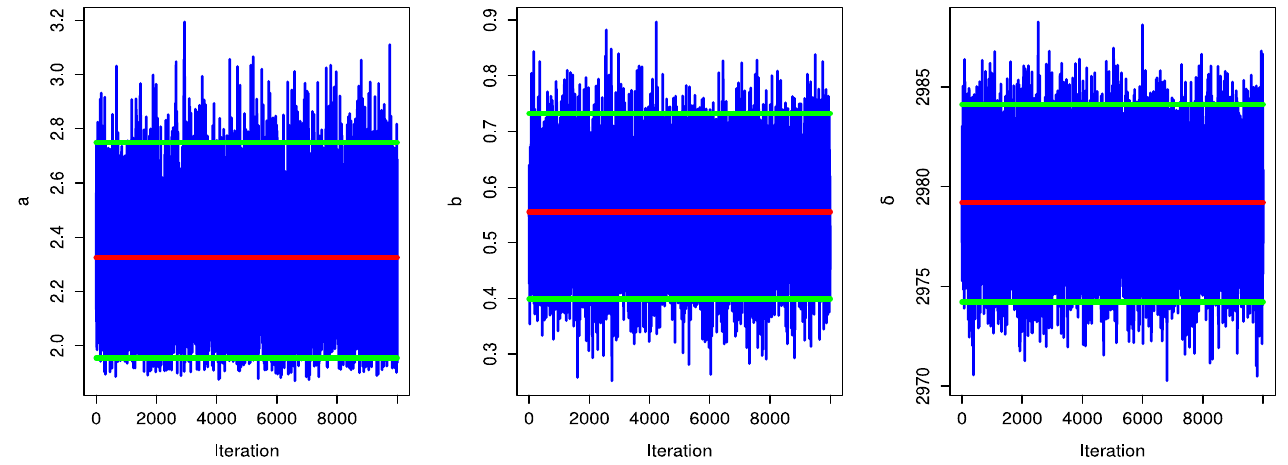
Figure 12. Trace plots of MCMC results with interval limit line for Saudi Arabia data set.